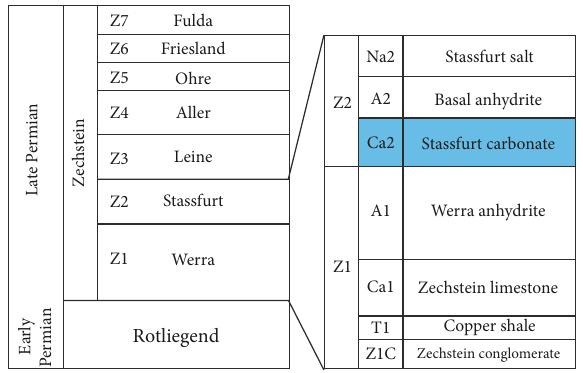
Figure 2: Simplified overview of the regional Zechstein stratigraphy of Germany (modified after Steinhoff and Strohmenger [34]).